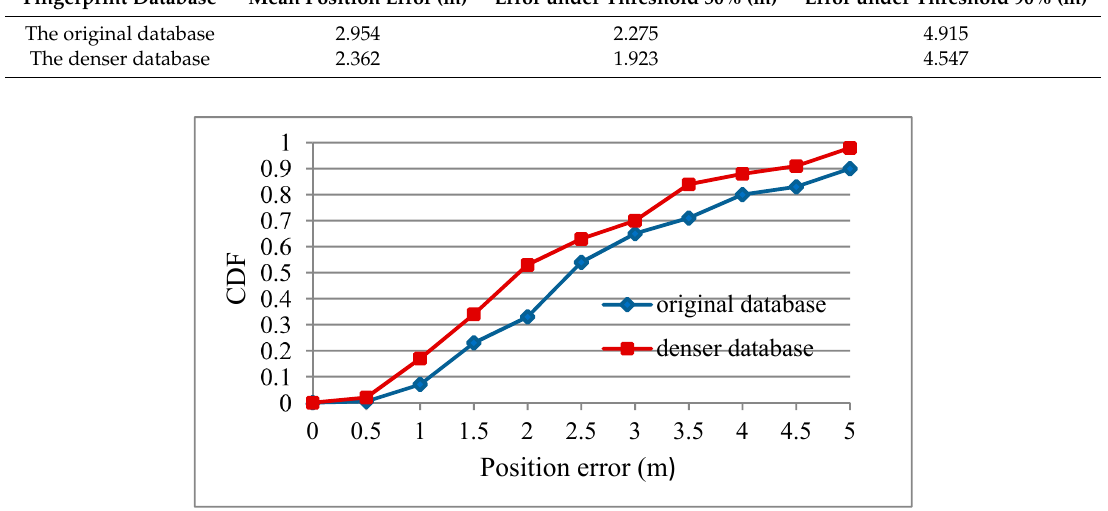
Table 3. Comparison of positioning performances with different fingerprint databases.